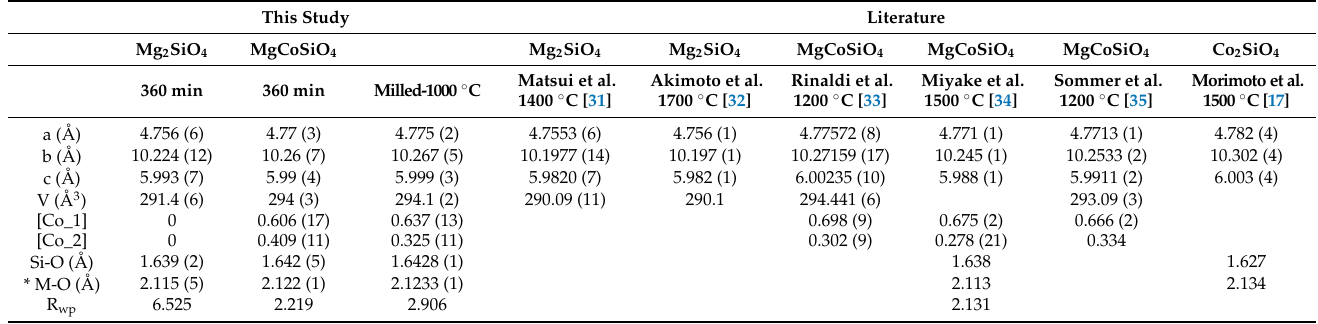
Table 1. Unit cell parameters obtained from the Rietveld refinement of the synthesized MgCoSiO 4, before and after heating in comparison with literature values.